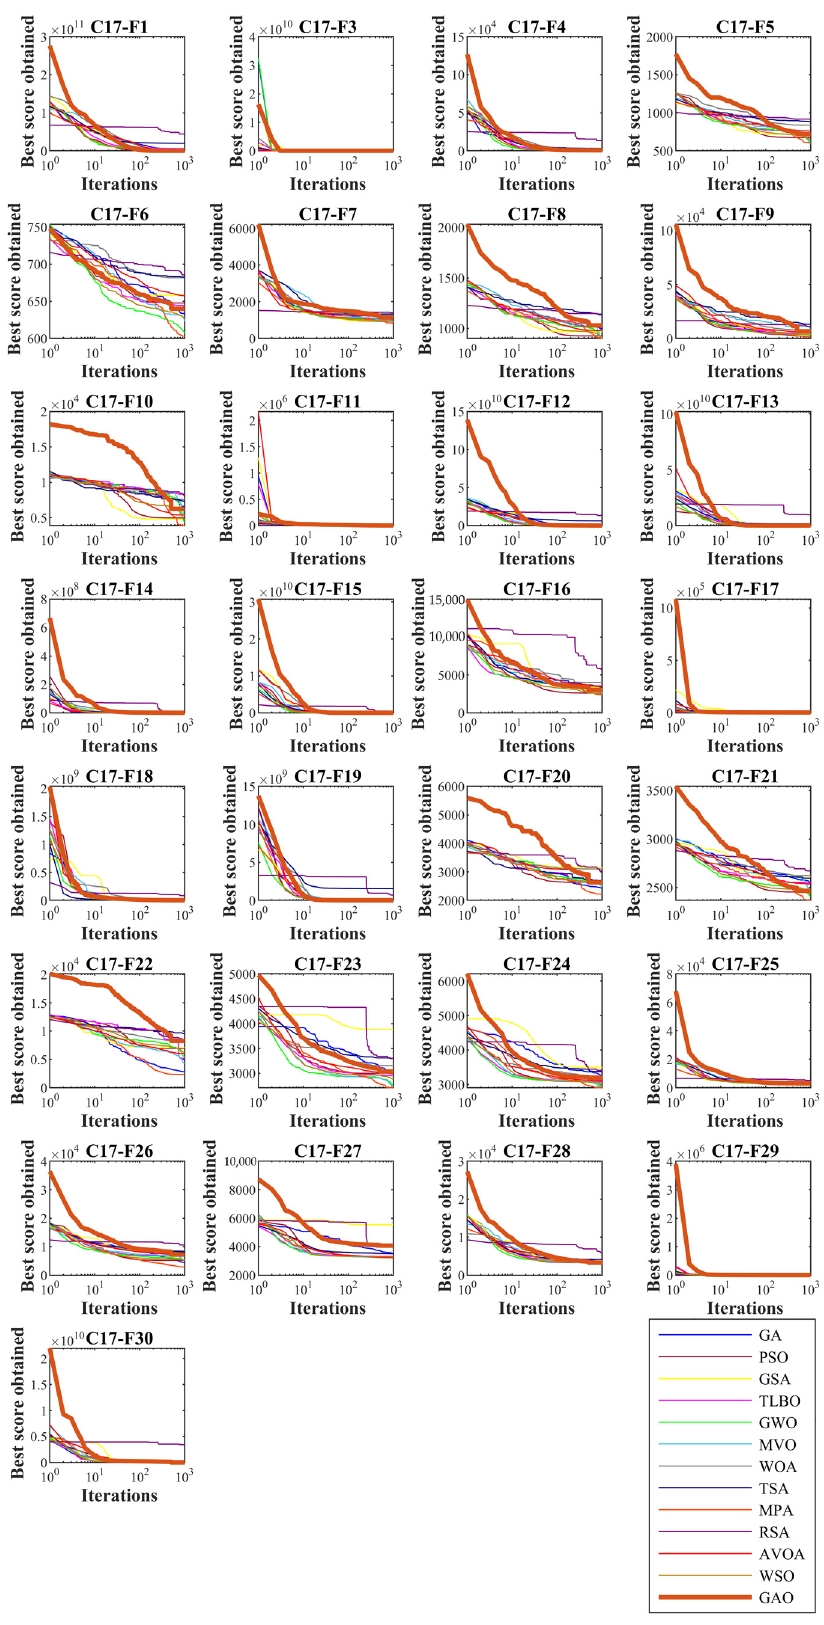
Figure 5. Convergence curves of GAO and competitor algorithms performance on the CEC 2017 test suite (dimension 𝑚 = 50 ).